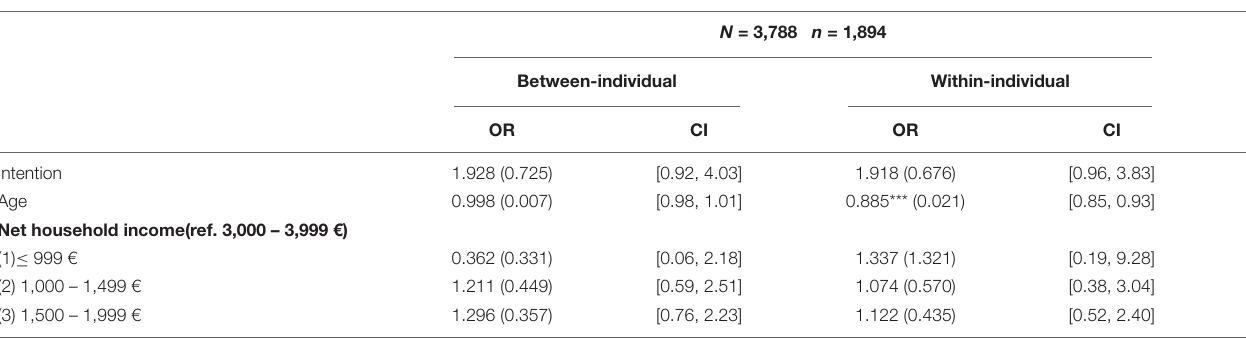
TABLE 4 | Results (Hypothesis